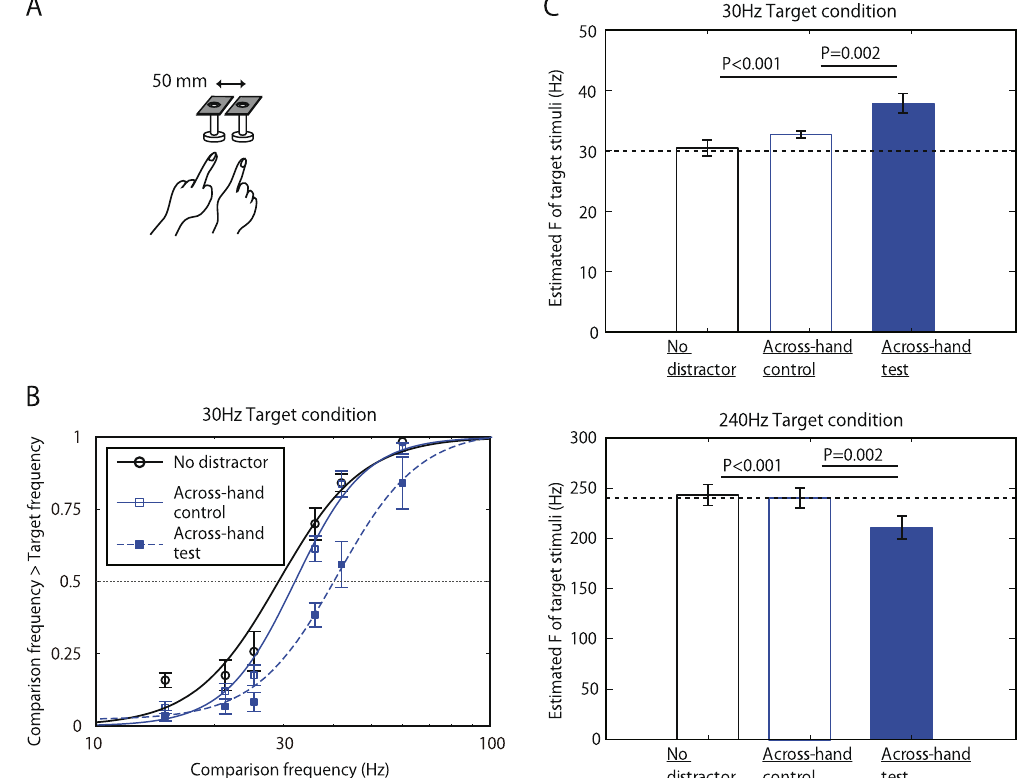
Figure 2. Frequency interaction Across-hand. ( A ) Schematic views of the set up. The distance between stimulators was the same to that in Across-finger conditions. ( B ) Psychometric functions of 30 Hz target condition. N = 10. Error bars indicate ± 1 SEM. ( C ) Perceived frequency of the target vibration of 30 Hz (top) and 240 Hz (bottom). N = 10. Error bars indicate ± 1